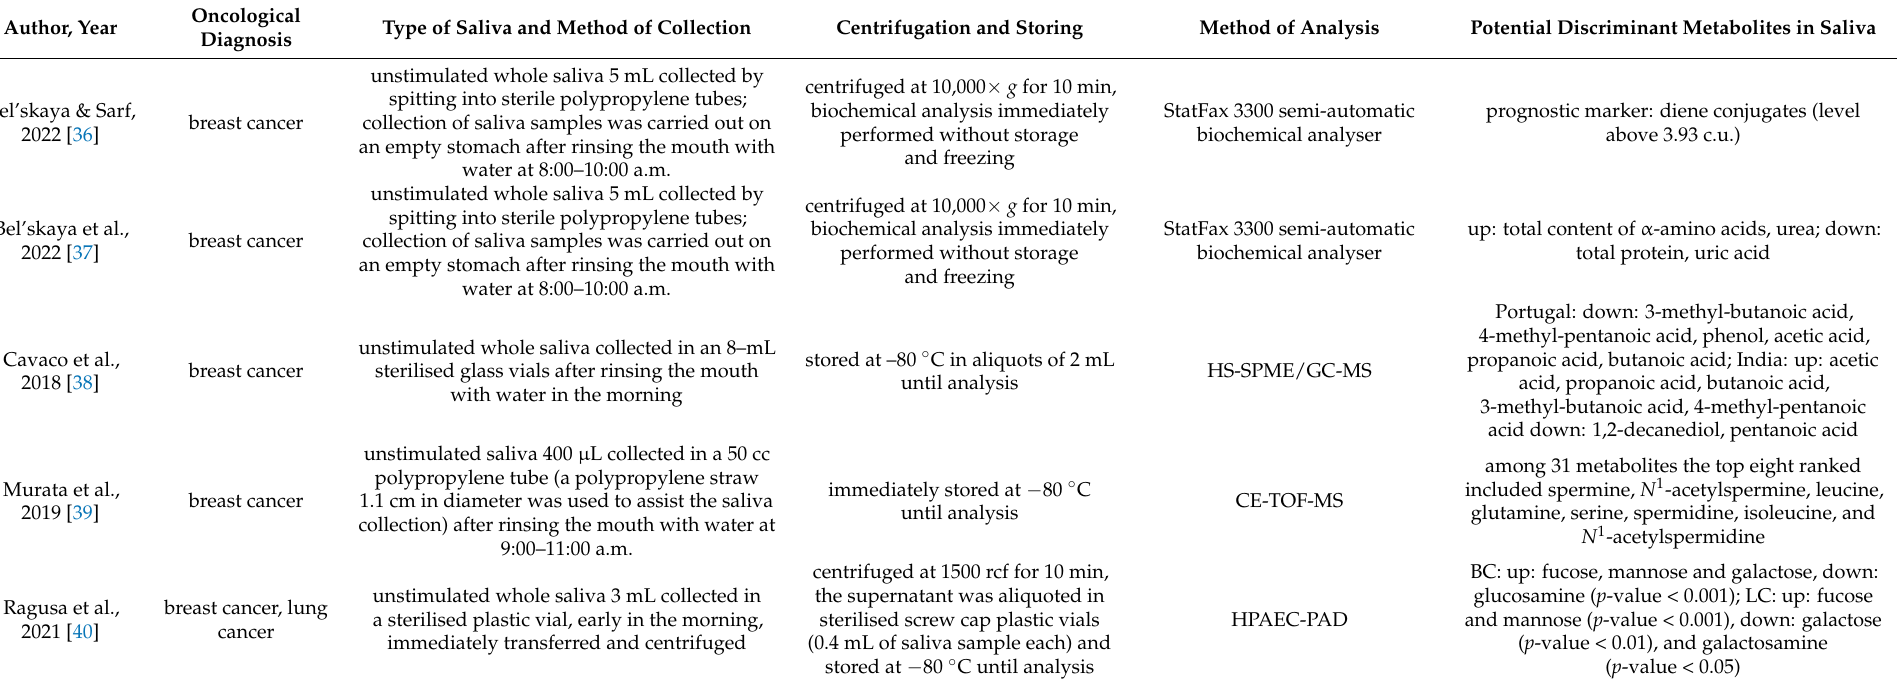
Table 3. Detailed characteristics of included studies considering methods of collection and analysis of